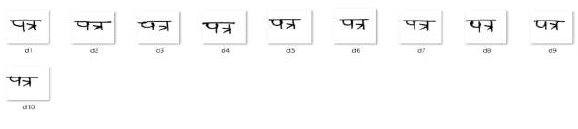
Fig. 3 . Handwritten Dataset of one person